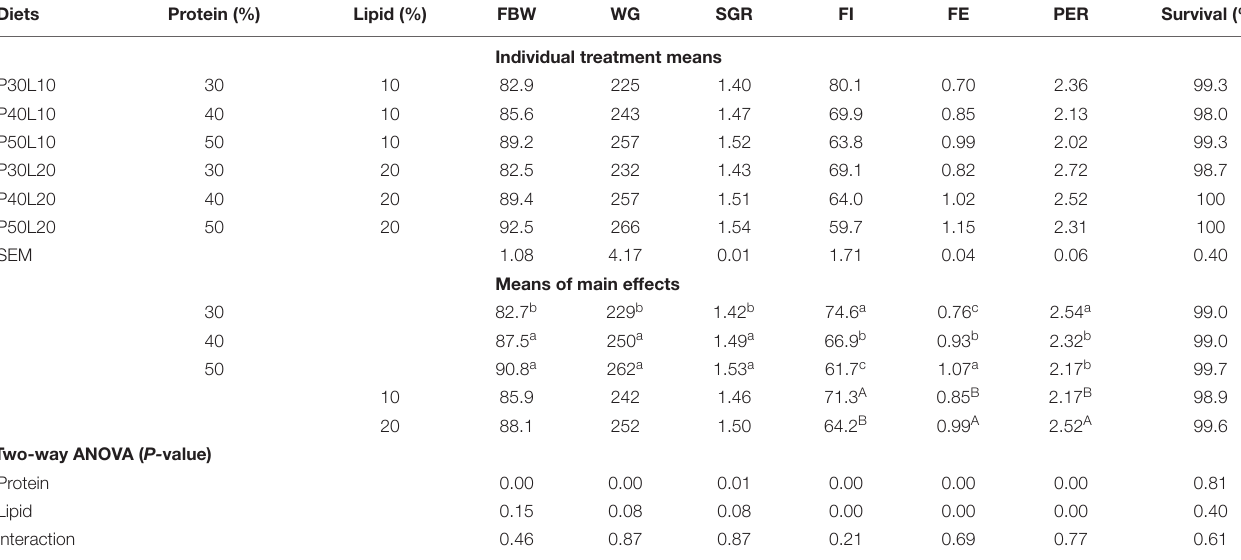
TABLE 2 | Growth, feed utilization and survival of European grayling ( Thymallus thymallus ) (25.2 ± 0.28 g) fed the experimental diets for 12 weeks. Diets Protein (%)